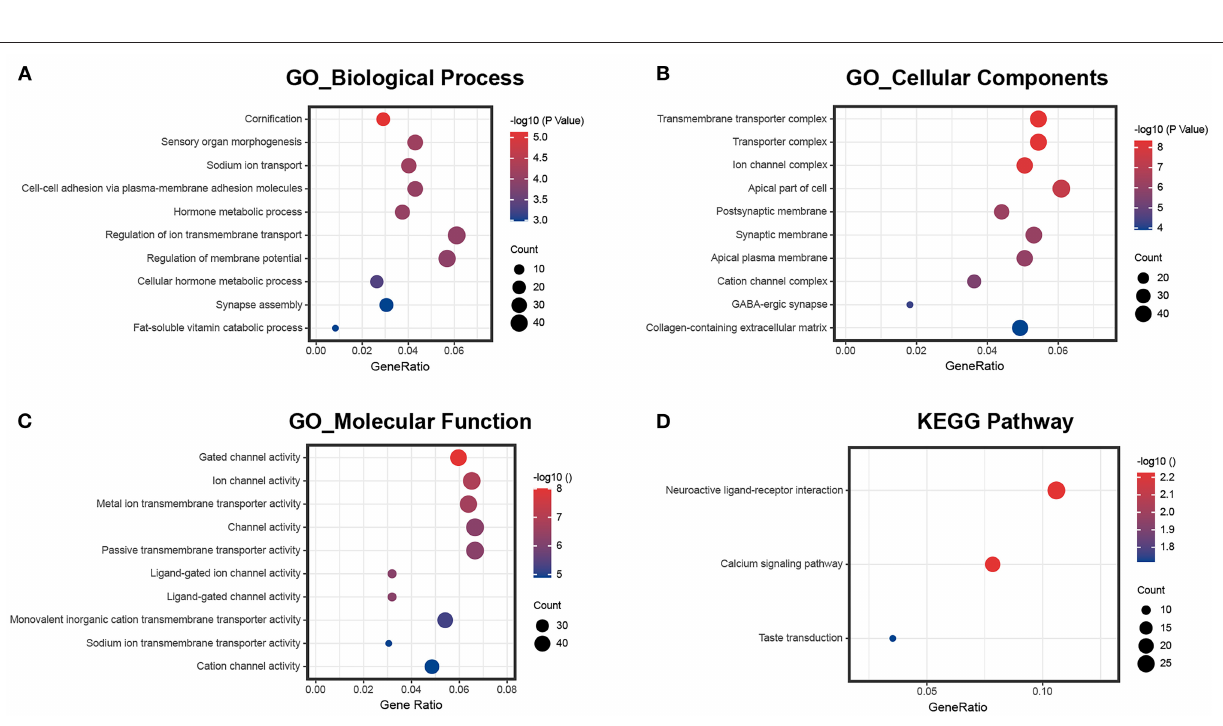
Frontiers in Neurology | www.frontiersin.org